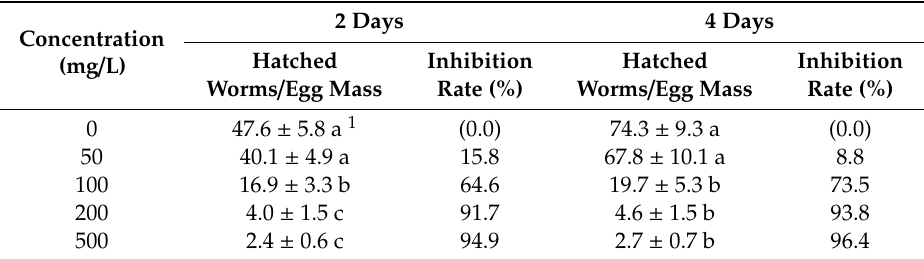
Table 1. E ff ect of FAc on the egg hatching of M. incognita